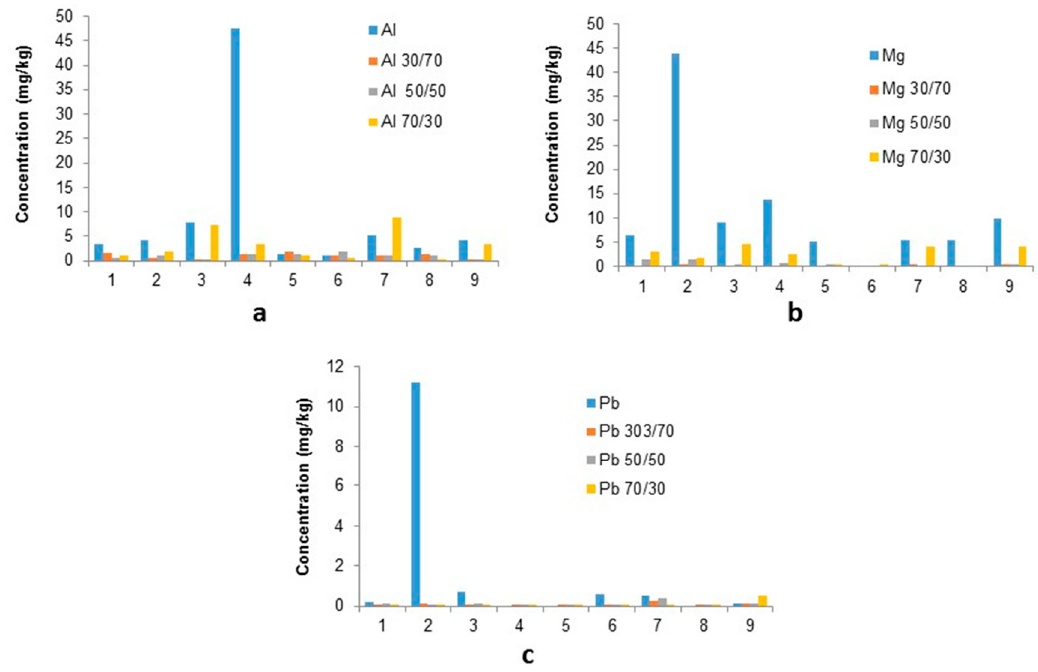
Figure 6. leachate concentrations in stabilised moulds compared to raw sinter ESP dusts: ( a ) Al; ( b ) Mg; and ( c ) Pb.